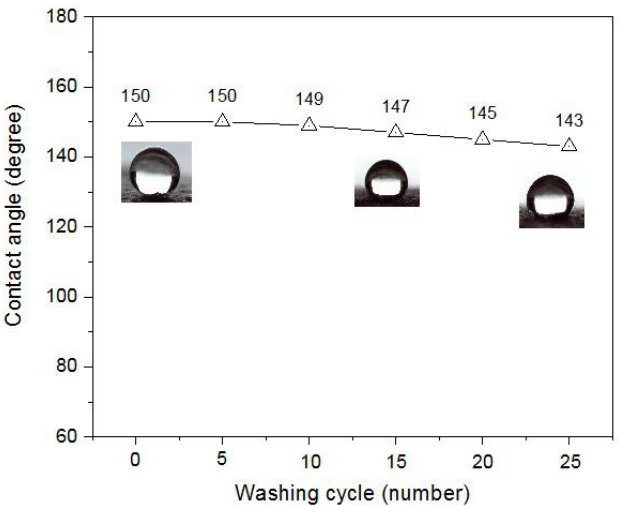
Figure 5. The contact angle of superhydrophobic fabrics as a function of washing cycles.